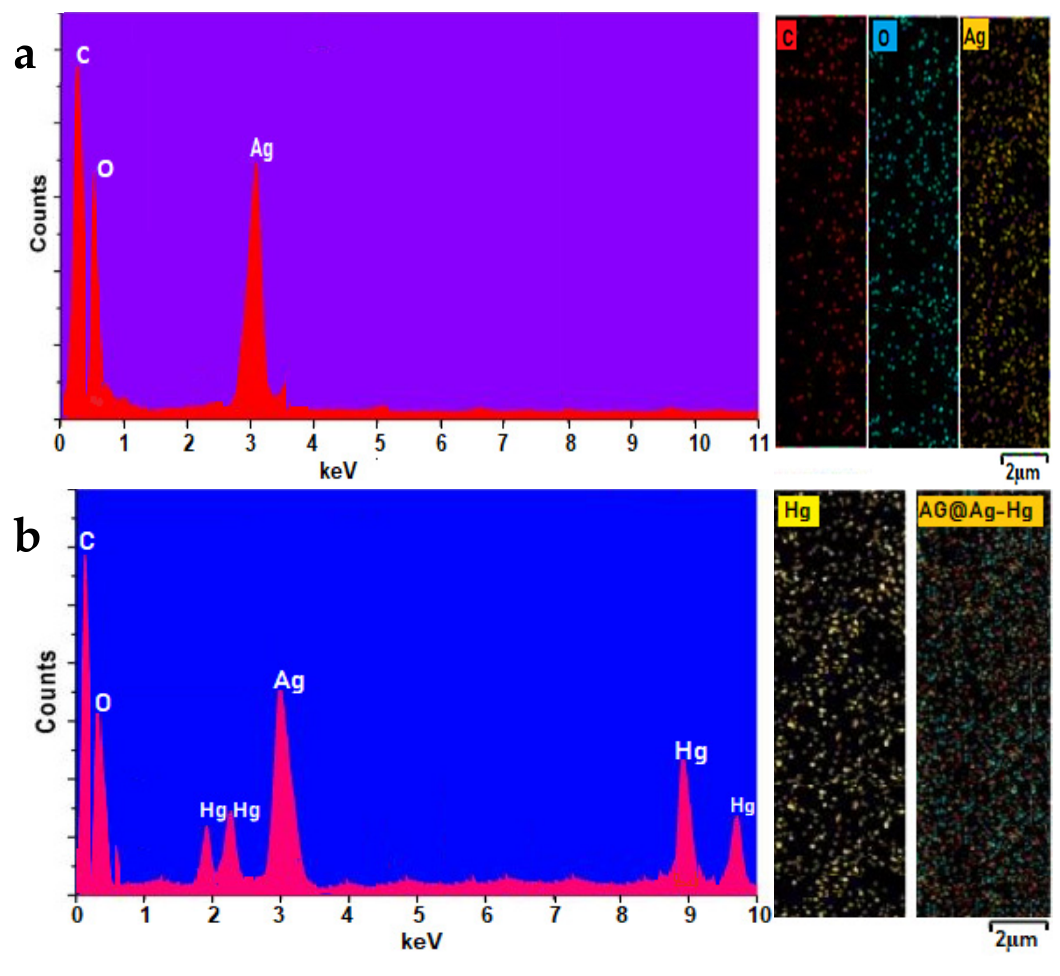
Figure 5. EDS measurements of AgNPs@AG supported with ESD ( a ) and Ag − Hg with supported ESD ( b ).